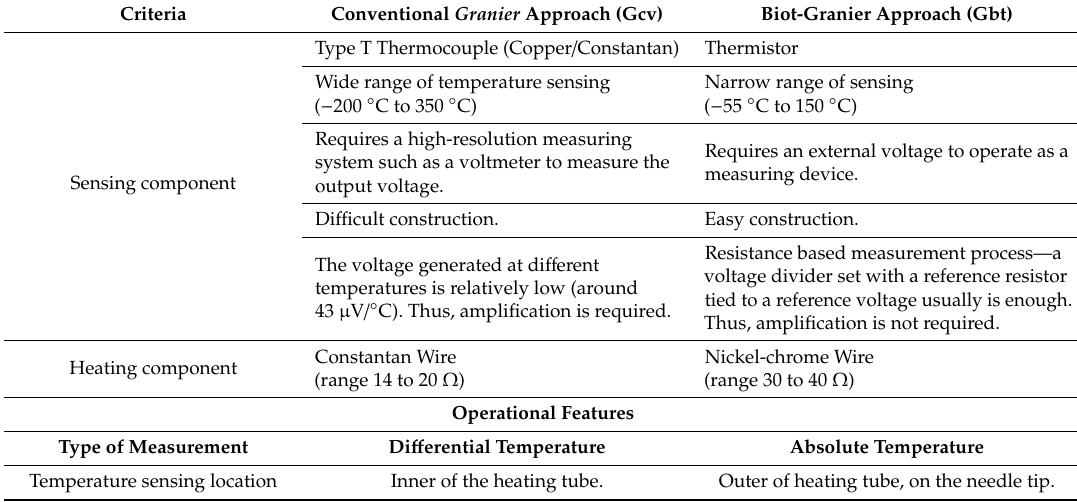
Figure 3. Building differences between Biot-Granier sensors ( right ) and conventional sensors ( left ). Table 1. Technical comparison between the original Granier sap flow and the Biot-Granier sensor.